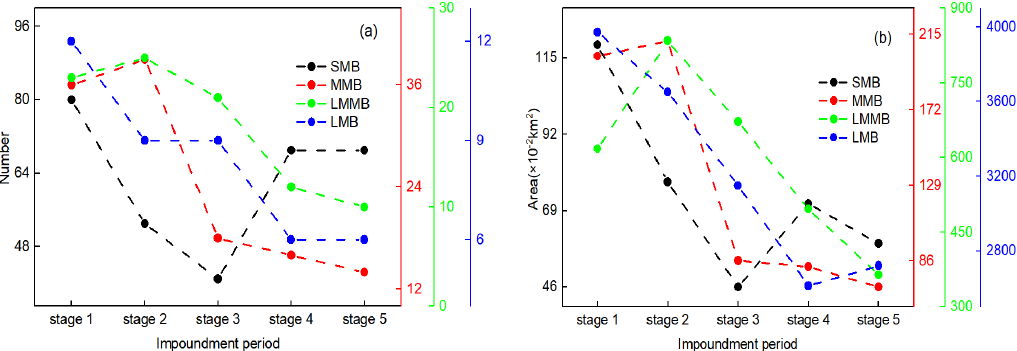
Figure 4. Number and area changes in MCBs with different sizes: ( a ) number, ( b ) area